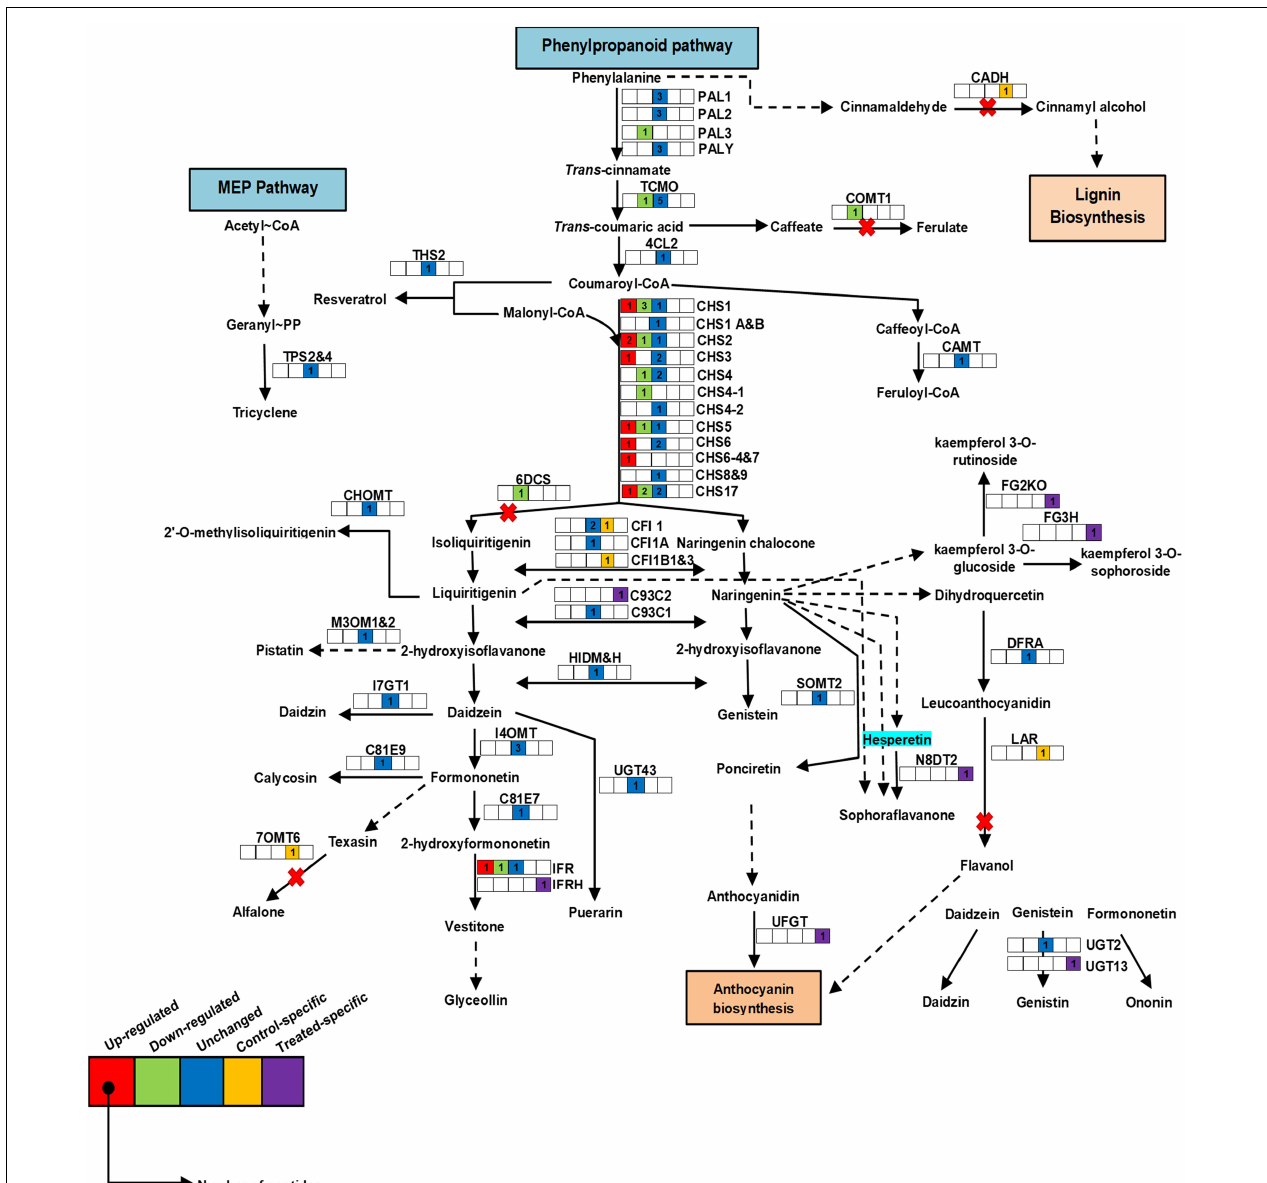
FIGURE 6 | Schematic representation of secondary metabolic pathway in roots of P. pinnata . Relative expression of protein species related to the phenylpropanoid pathway. Color key represents fold expression, and number indicates identified peptides: red color: high abundant protein species; green color: low abundant protein species, blue color: unchanged protein species; yellow color: control specific protein species; violet color: treated specific protein species. CHS, chalcone synthase; PAL, phenylalanine ammonia lyase. For protein abbreviations, see Supplementary Table 1 .